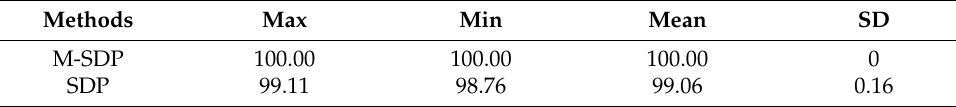
Figure 13. The training process with using M-SDP and SDP: (a) validation accuracy curves; (b) training loss curves. Table 4. The testing results using M-SDP and SDP (%).